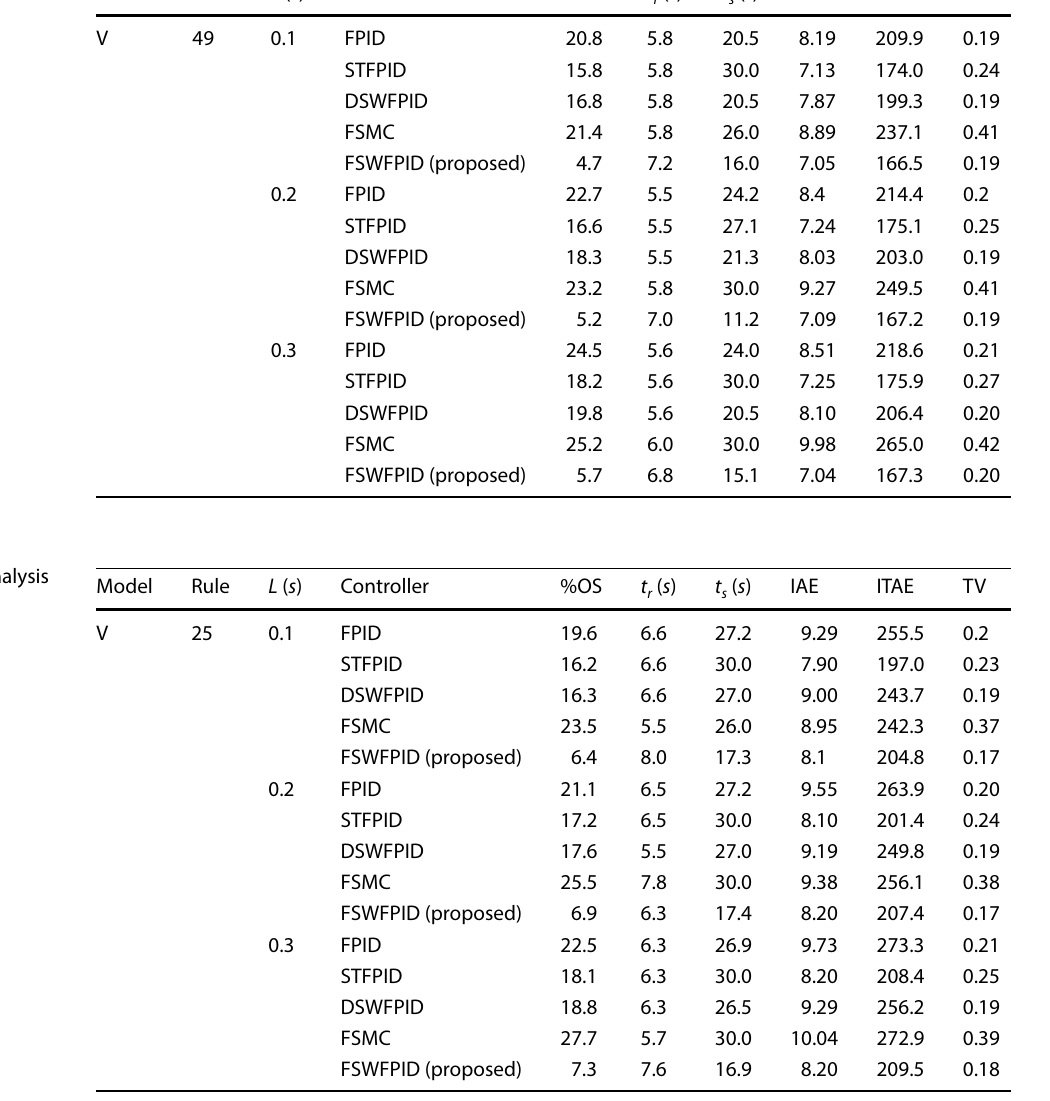
Table 15 Performance analysis for Model V